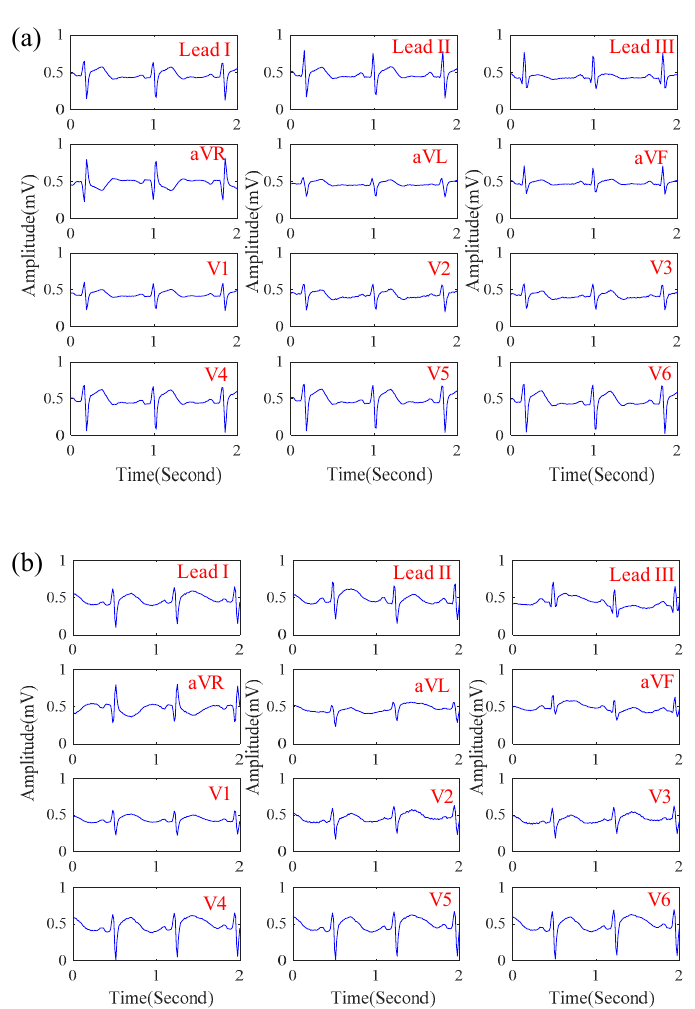
Figure 7. The 12-lead ECG signals obtained by the proposed system when ( a ) sitting and ( b ) walking.